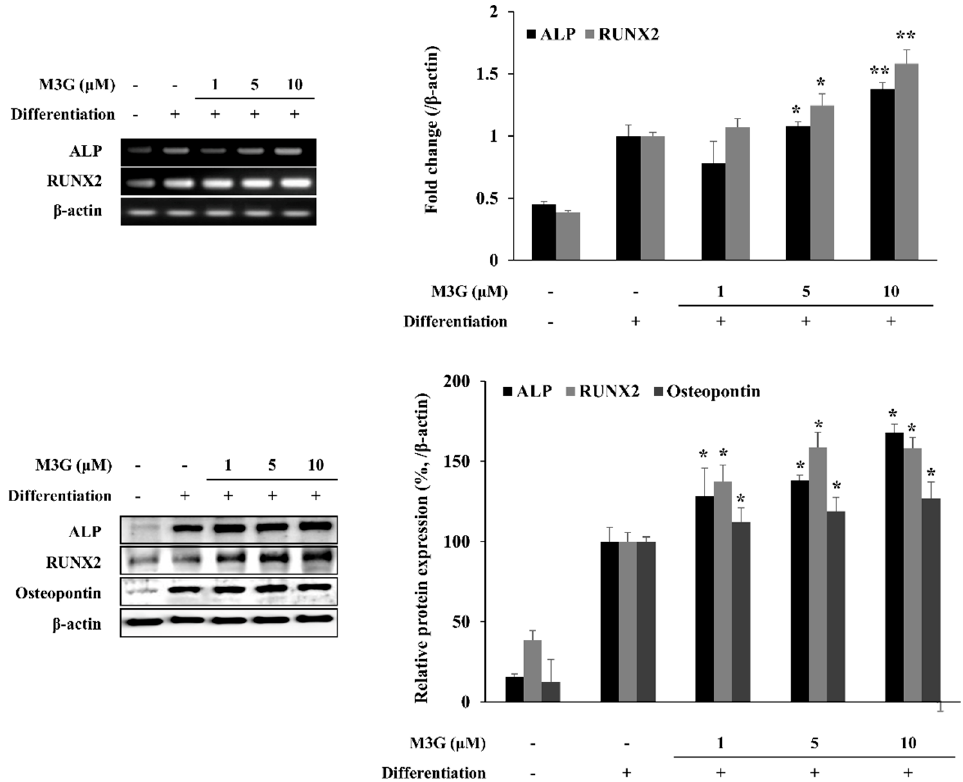
Figure 3. Effect of M3G on osteoblastogenesis marker gene expression. Analysis of gene expression was carried by measuring mRNA and protein levels in osteo-induced hBM-MSCs via RT-PCR and Western blot, respectively, at day 10 differentiation. Osteo-induced hBM-MSCs were treated with M3G until day 3 of differentiation. * p < 0.05, ** p < 0.01 vs. differentiated untreated group.